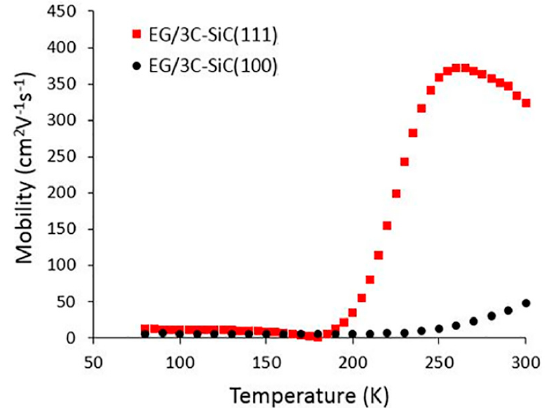
Figure 16. Temperature dependent mobility between 80 and 300 K for (100) and (111) EG/3C-SiC. Reprinted from Reference [21]. Copyright (2020) American Chemical